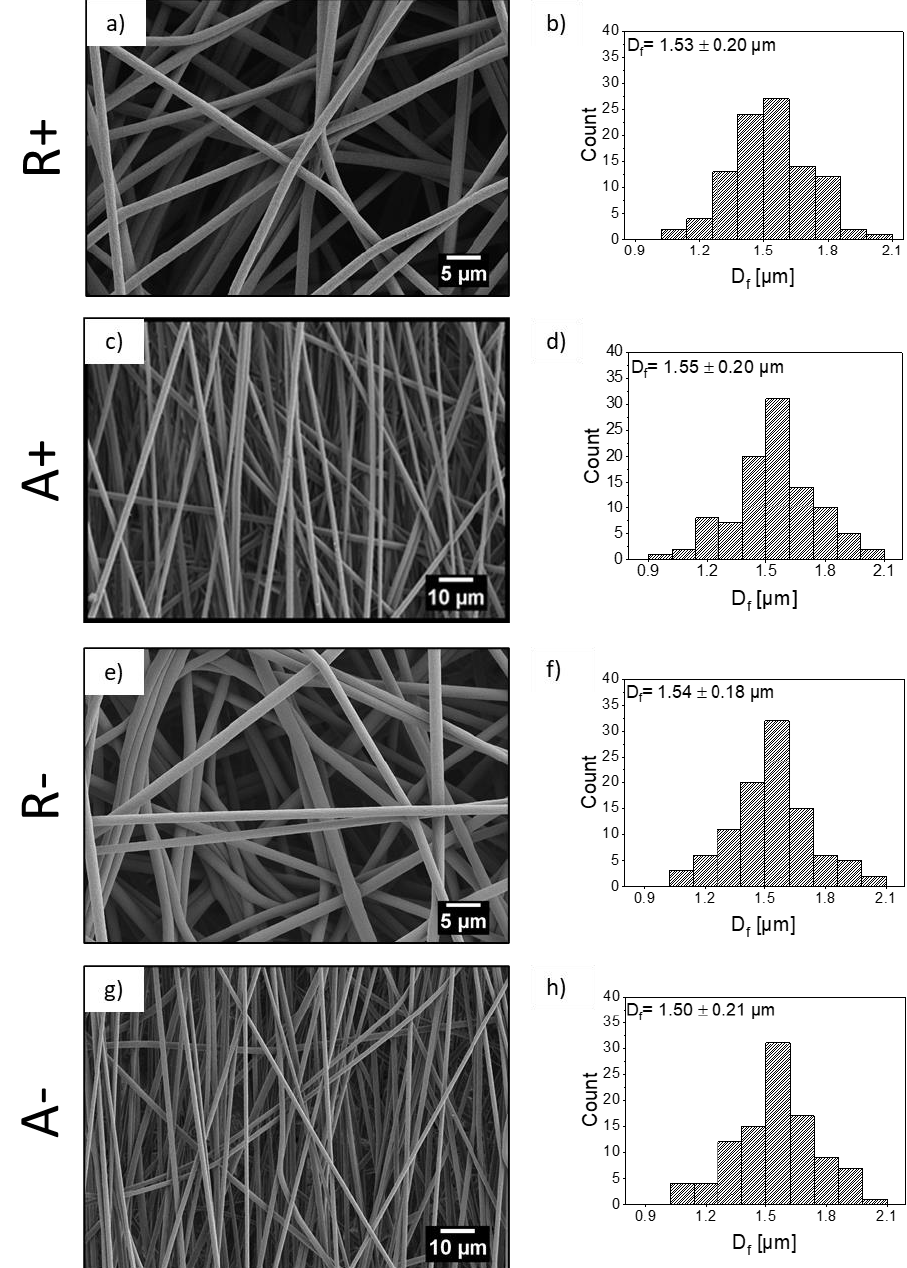
Figure 3. Scanning electron microscopy (SEM) micrographs of PMMA + random, R and aligned, A fiber mats ( a , c ) with histograms showing the fiber diameter distribution and ( b , d ) PMMA − random, R and aligned, A fiber mats ( e , g ) with histograms showing the fiber diameter distribution ( f , h ).